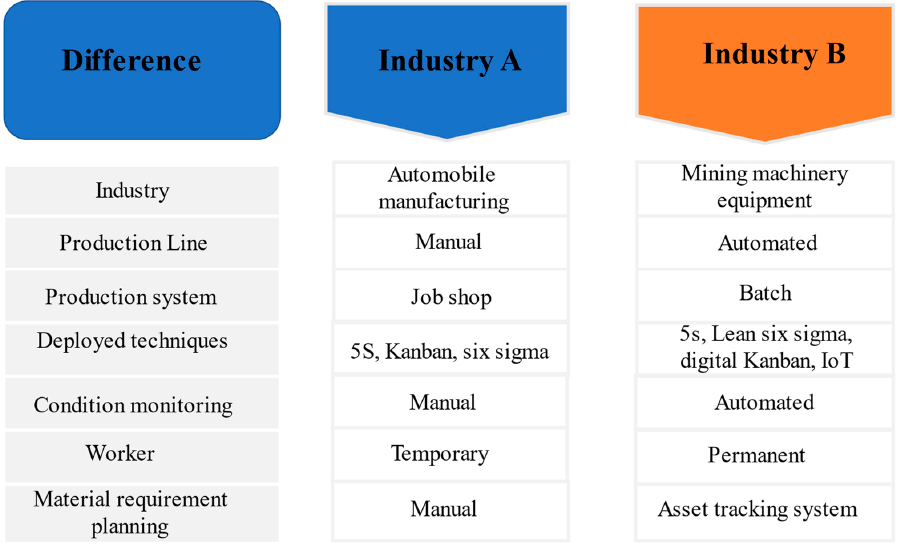
Figure 5. Differences between industry A and industry B .